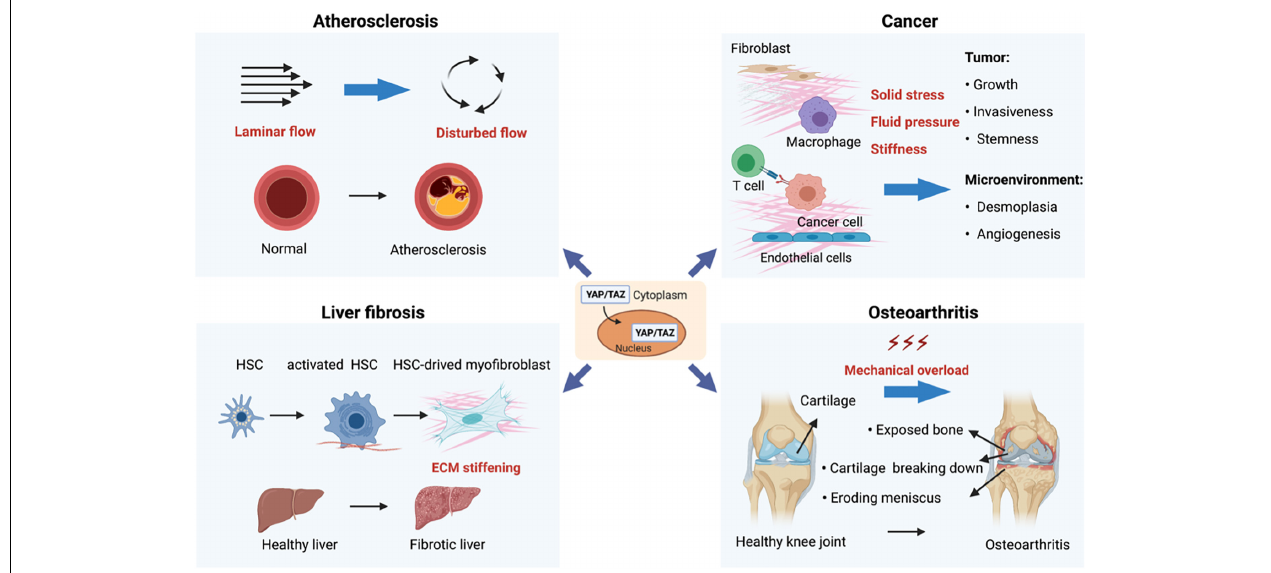
FIGURE 3 | Mechanoregulation of YAP/TAZ in human diseases. (1) Disturbed flow-activated YAP/TAZ is a key factor that promotes atherogenesis. (2) Mechanical properties in the tumor microenvironment (such as solid stress, fluid pressure, and stiffness) act through YAP/TAZ to regulate various aspects of tumor initiation and progression. (3) YAP/TAZ-mediated mechanoresponses strongly promote organ fibrosis. For instance, hepatic injuries and subsequent inflammatory responses activate quiescent hepatic stellate cells (HSCs), leading to activation and expansion of HSCs and accumulation of extracellular. (4) Osteoarthritis (OA) is mainly caused by mechanical overload, and YAP is both necessary and adequate to preserve cartilage homeostasis in